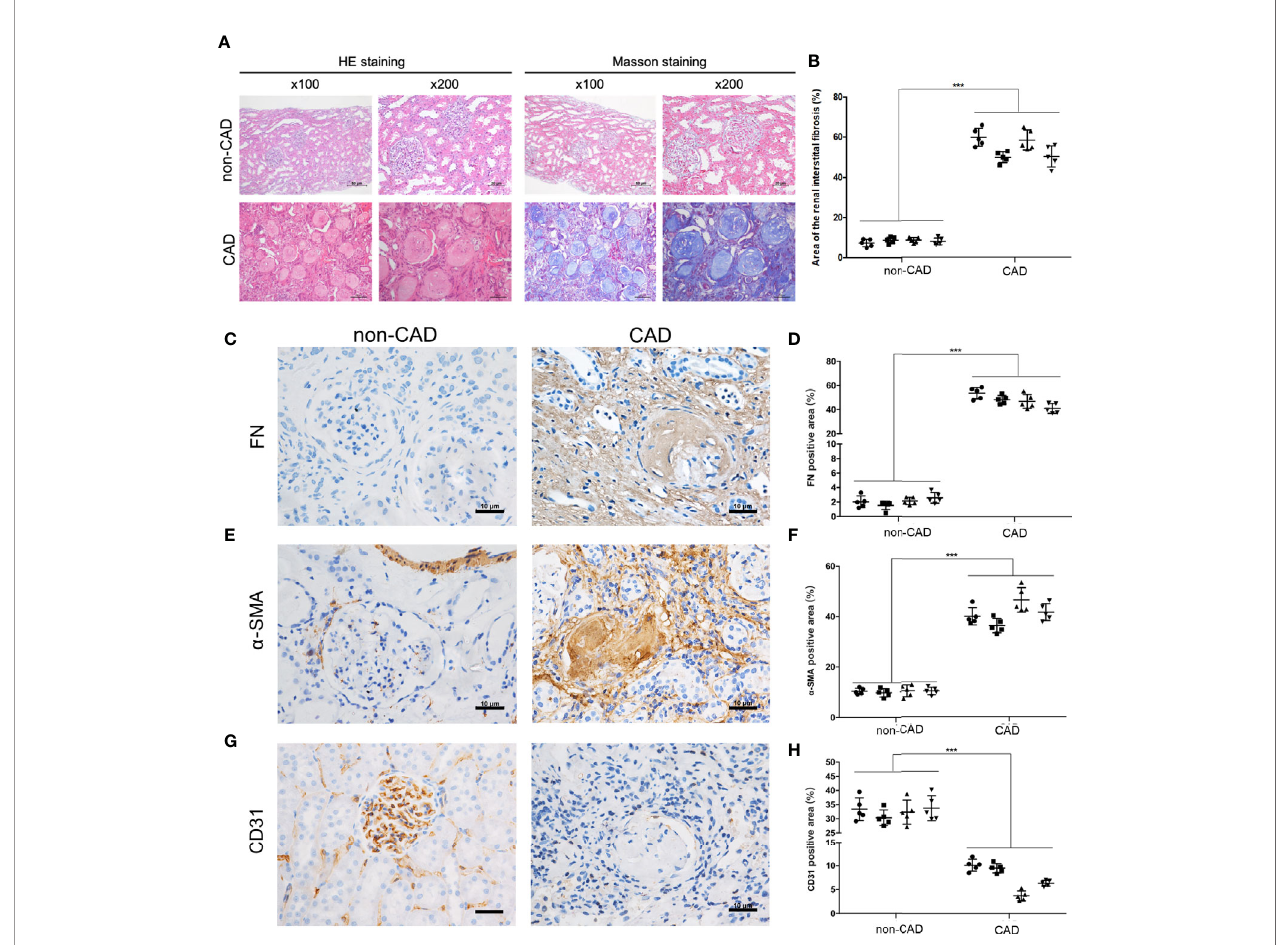
FIGURE 1 | Pathological and morphological changes in kidney tissues from the non-CAD and CAD patients. (A) Representative kidney sections from the non-CAD and CAD patients were stained with HE and Masson trichrome (×100, scale bar: 50 m m, ×200, scale bar: 20 m m). (B) Semi-quantitative analyses of the degree of fi brosis in 4 non-CAD patients ’ and 4 clinical CAD patients ’ kidney sections stained with Masson trichrome were performed. Each patient selected 5 different sites of transplanted kidney. (*** P < 0.001, CAD vs. the non-CAD group, Student t test). (C, E, G) Distributions and expressions of FN, a -SMA and CD31 in the CAD and non-CAD group were assessed by IHC staining assays (×400, scale bar: 10 m m). (D, F, H) Percentage of the relative abundance of proteins were presented as the mean ± SD values of fi ve independent experiments. Representative images of the kidney tissues of the non-CAD group (n = 4) and CAD group (n = 4) were shown. Each patient selected 5 different sites of transplanted kidney. (*** P < 0.001, CAD vs. the non-CAD group, Student t